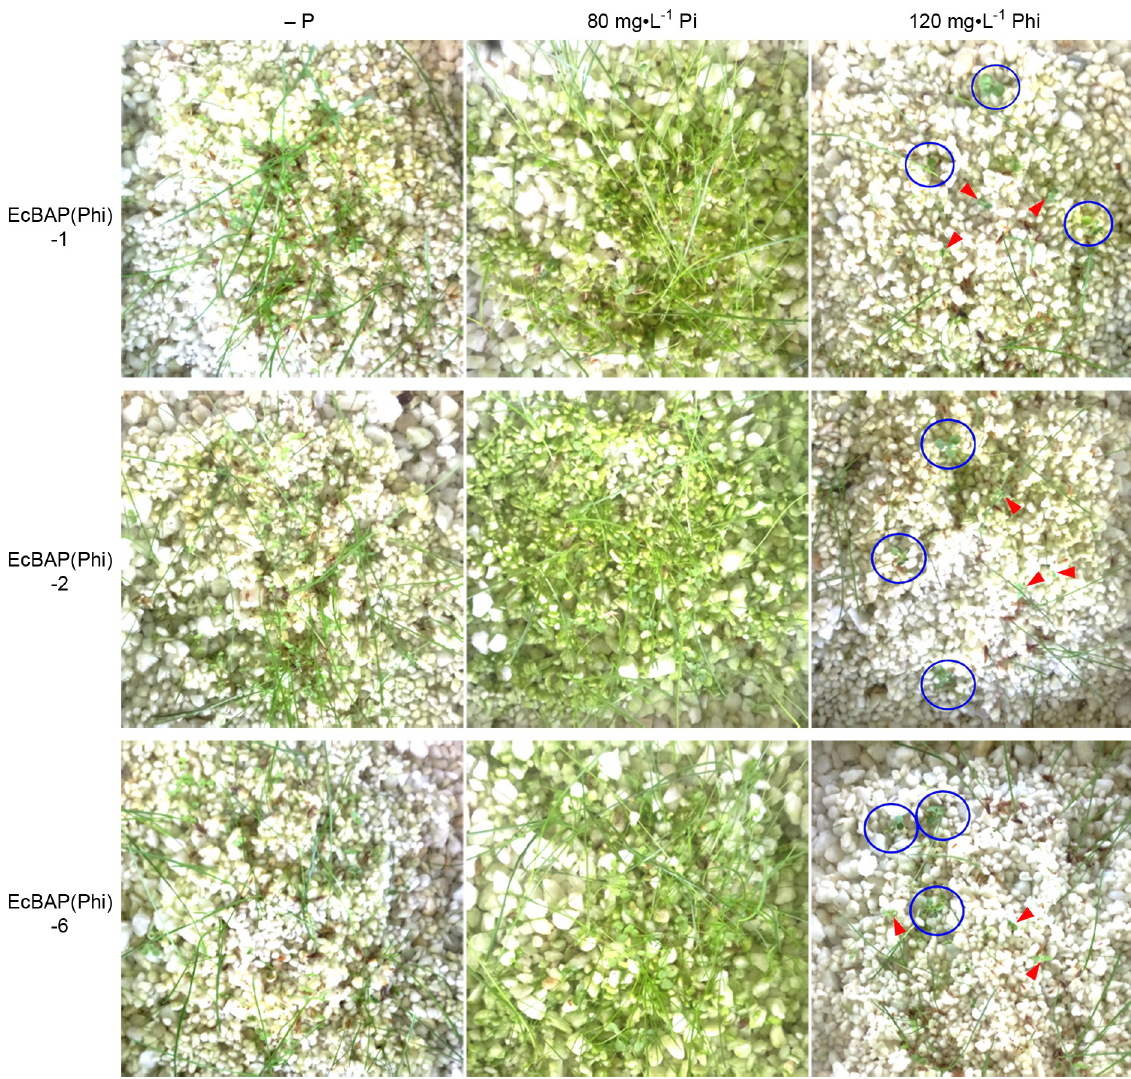
Fig 6. Weed control simulation test by judging the competitive growth of EcBAP(Phi) transgenic tobacco versus weed and WT tobacco. A seed mixture of WT tobacco, EcBAP(Phi) transgenic tobacco line (1, 2, or 6) and Tall fescue weed (at a ratio of 1:1:4) was evenly sowed on a matrix composed of perlite, vermiculite and little gravel, which was individually irrigated with 0.1 x MS (–P, +80 mg � L -1 Pi, or +120 mg � L -1 Phi). After 15 days of standard cultivation in greenhouse, the growth status of mixed seedlings was photo-recorded and compared. Under the condition of 120 mg � L -1 Phi, the growth-dominant tobacco seedlings were circled in blue, while those inhibited individuals were marked by red arrow-heads.